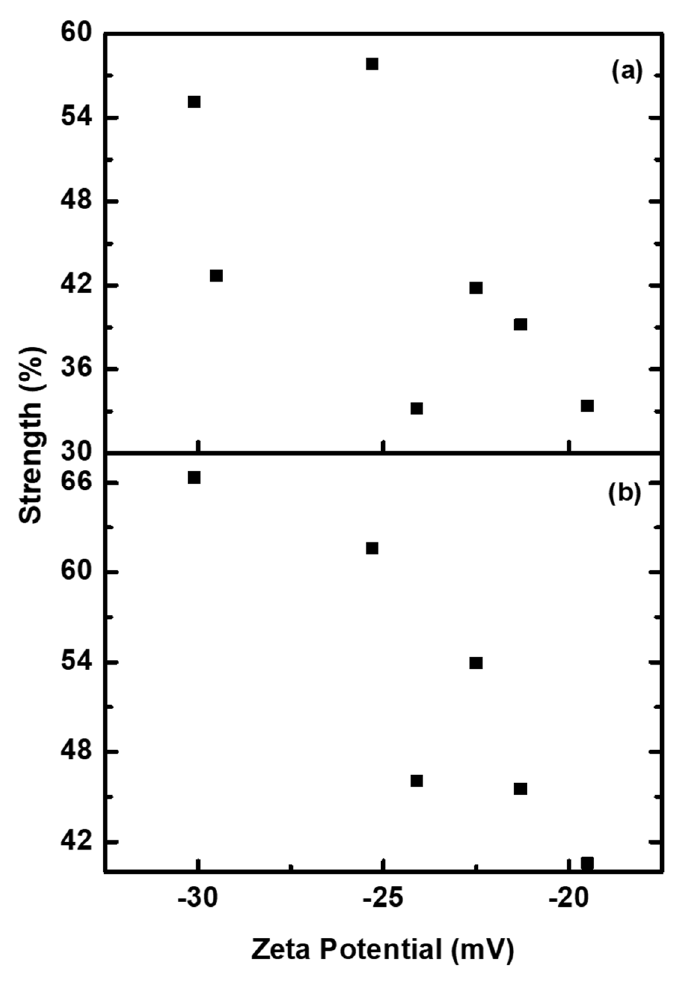
Figure 15. Strength of printed cotton fabrics after washing, ( a ) BR and ( b ) BV, as a function of zeta potential.